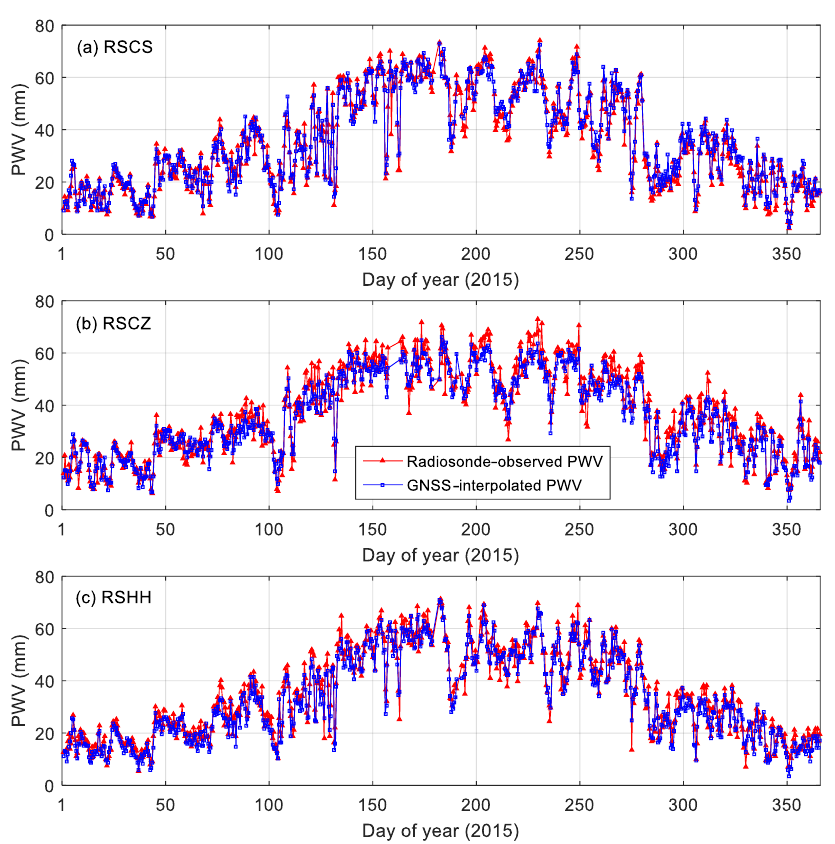
Figure 4. Time series of PWV measured by radiosonde and interpolated by GNSS over the whole year of 2015 at three radiosonde stations: